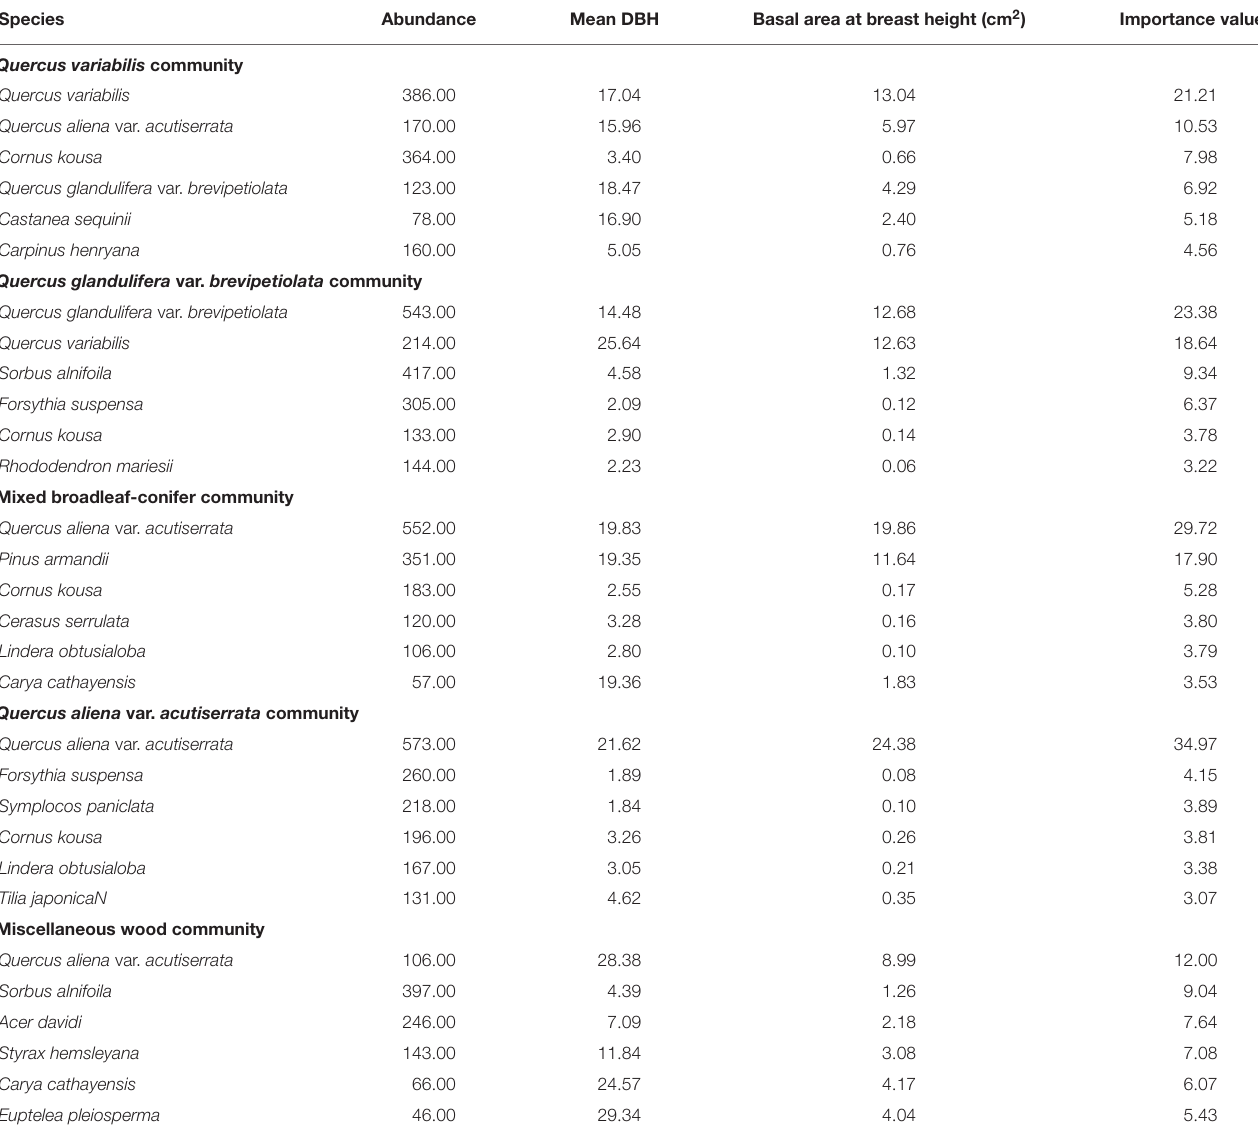
TABLE 1 | Dominant species in five